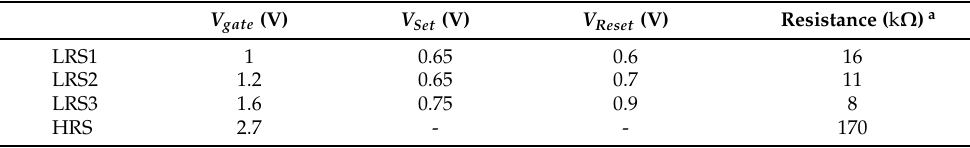
Table 1. Electrical characteristics for the different resistance levels.